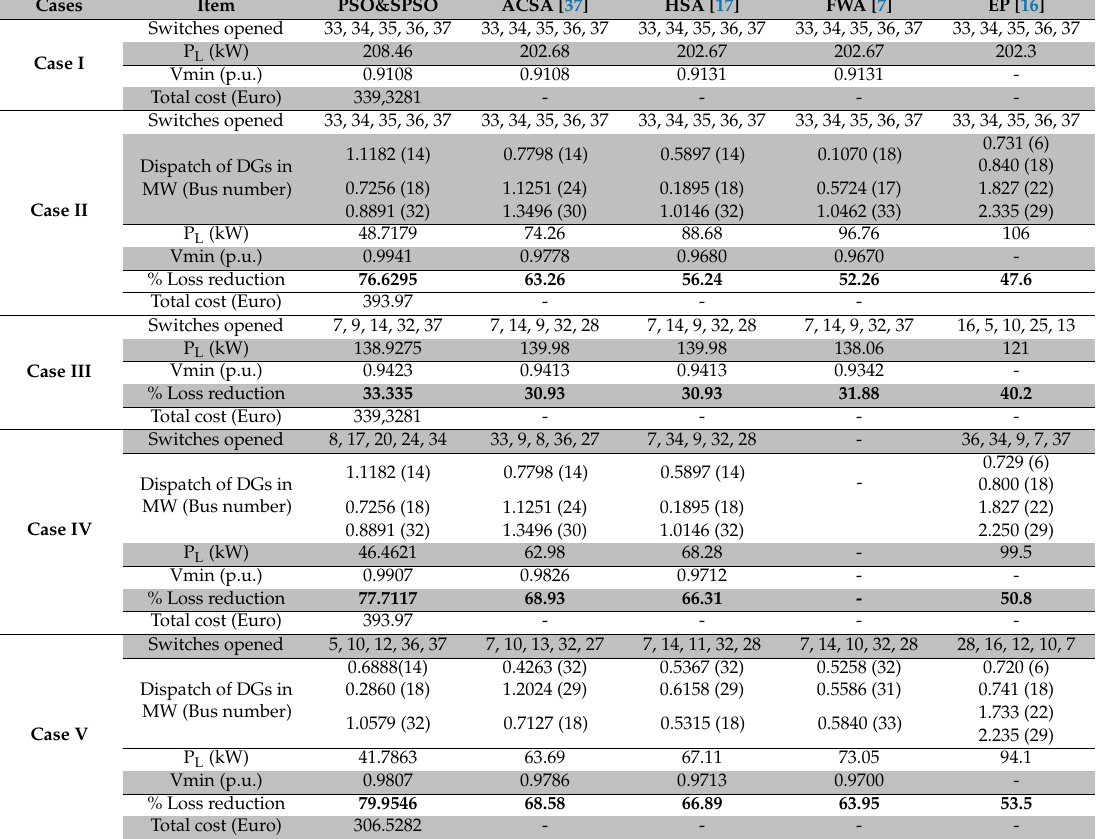
Table 5. A comparative study of a microgrid (MG) operation management